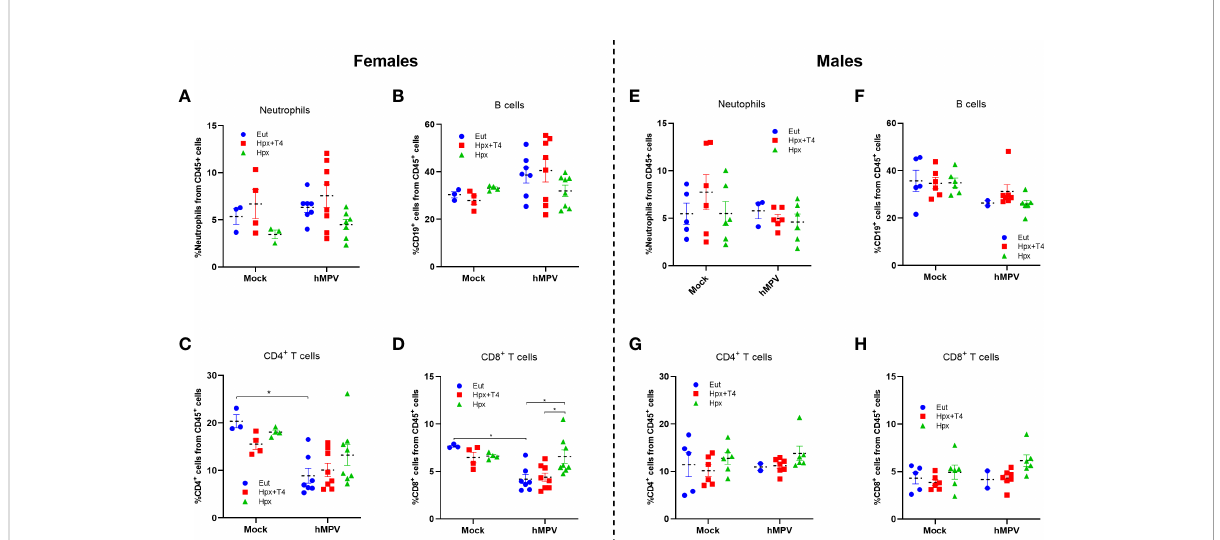
FIGURE 2 The hMPV infection increased the proportion of CD8+ T cells in the female Hpx progeny. Flow cytometry of single-cell suspension on CD45 + cells from lung seven days post-infection with 1x10 6 PFU hMPV or mock were performed for Eut, Hpx+T4 and Hpx gestated mice. (A, E) Neutrophils (CD11c - CD11b + Ly-6G + SIGLEC-F - ), (B, F) B cells (CD3 - CD19 + ), (C, G) CD4 + T cells and (D, H) CD8 + T cells were analyzed for female (A – D) and male (F – H) mice. Data are shown as the mean ± SEM of at least three animals per group. *p < 0,05 by two-way ANOVA and Tukey ’ s multiple comparisons